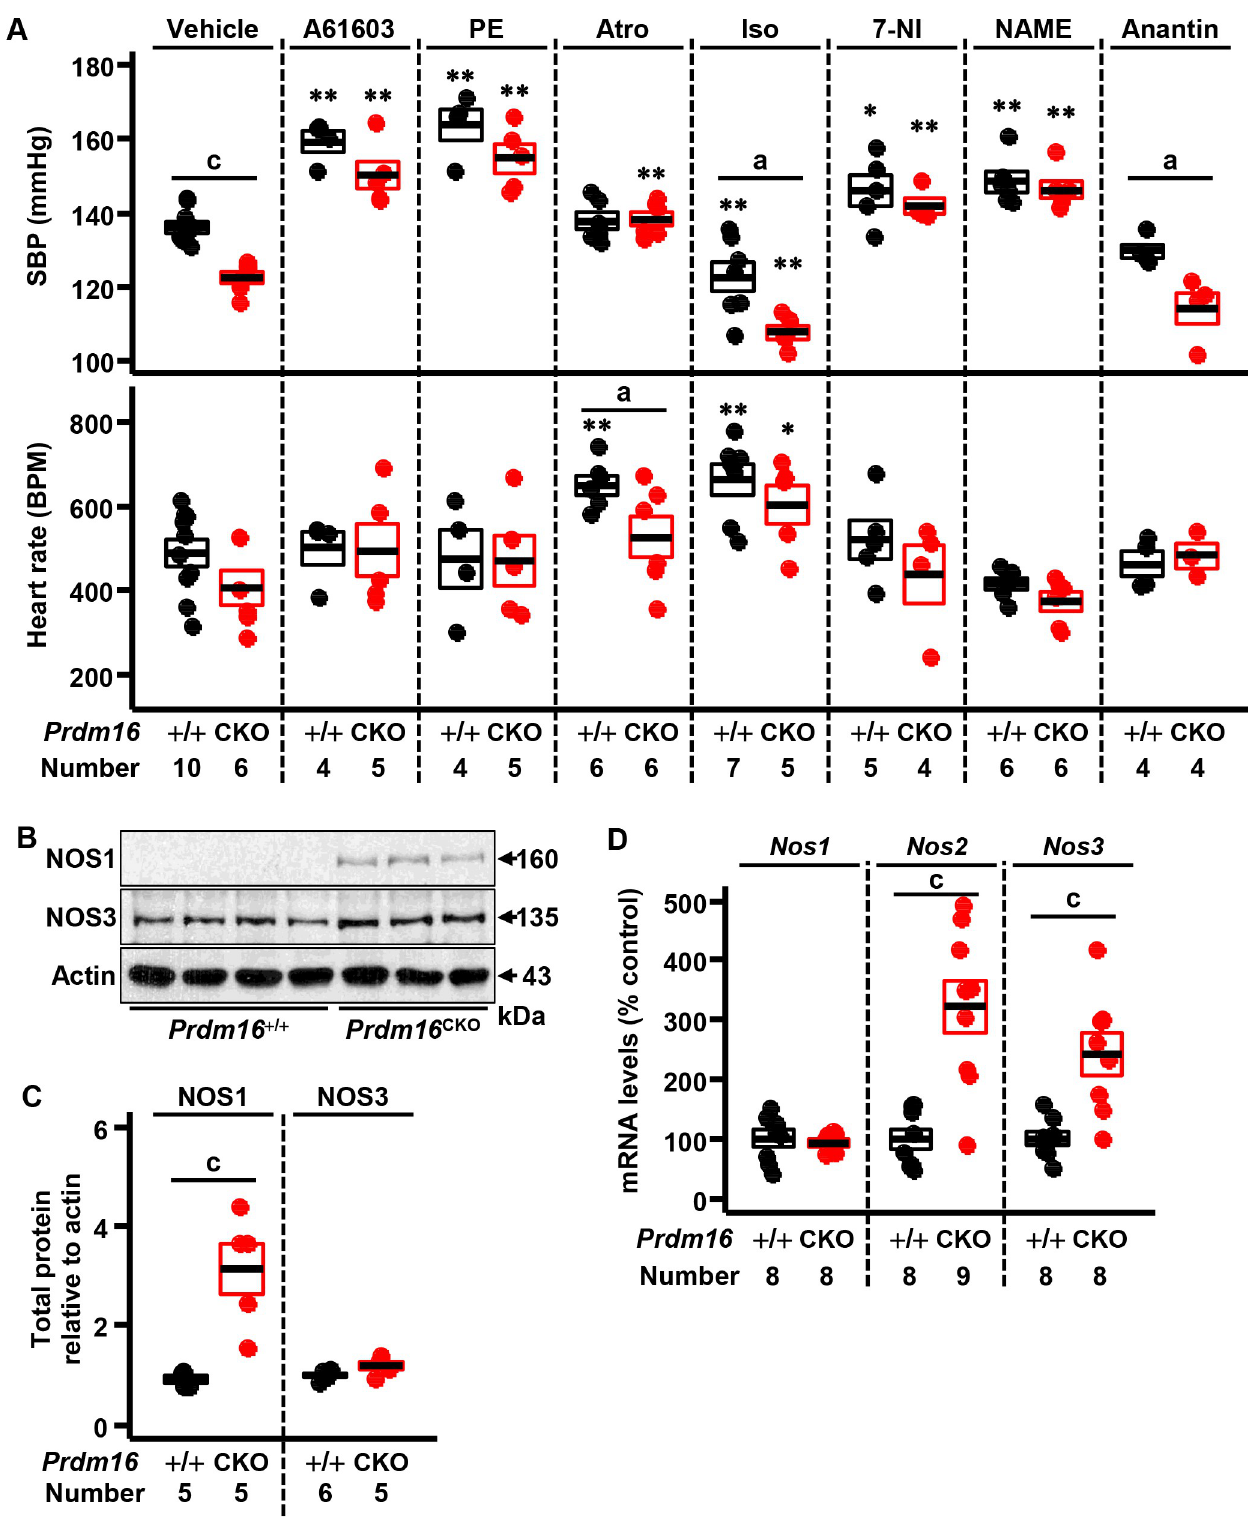
Fig 6. Pharmacological restoration of hypotension in mice with cardiac deficiency of Prdm16 . (A) SBP and heart rate were measured via a telemetric implant in 5-month-old female Prdm16 CKO and control mice after vehicle (saline, except for atropine) or pharmacological administration. (B-C) NOS1 and